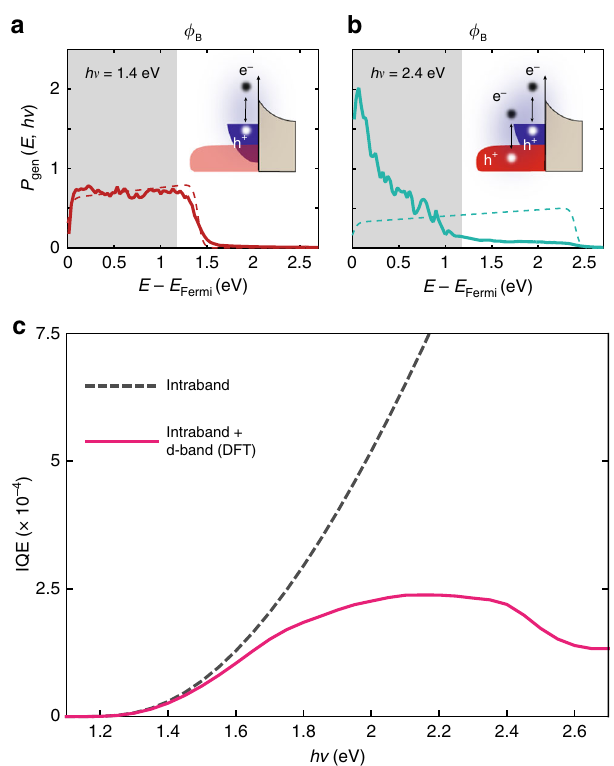
Fig. 3 Impact of interband and intraband transitions on IQE of hot carrier devices. a Prompt hot electron energy distribution ( P gen ) showing the carrier energy E above the Au Fermi level ( E F ) calculated with DFT (solid line) as well as under the parabolic band approximation (Fowler-like model, dashed line) for incident photon energies ( h ν ) of 1.4 eV and b 2.4 eV. The shaded area in both plots depicts the position of the Schottky barrier, Φ B , limiting the possibility of collection to those carriers with energy E − E F > Φ B . The insets show a schematic of the metal and semiconductor band structure illustrating the predominance of intraband transitions ( a ) and co- existence with interband transitions ( b ) as well as the presence of the Schottky barrier at the interface; c IQE spectra calculated based on the P gen obtained with DFT (magenta solid curve), i.e., including interband transitions, as well as with parabolic band approximation (gray dashed curve), i.e., accounting only for intraband transitions. For the injection process, conservation of tangential momentum is assumed 21 . Transport of hot electrons within the metal nanostructure has been with the height of our Schottky barrier (gray shaded area in Fig. 3a, b — see also Supplementary Note 3), results in a reduction